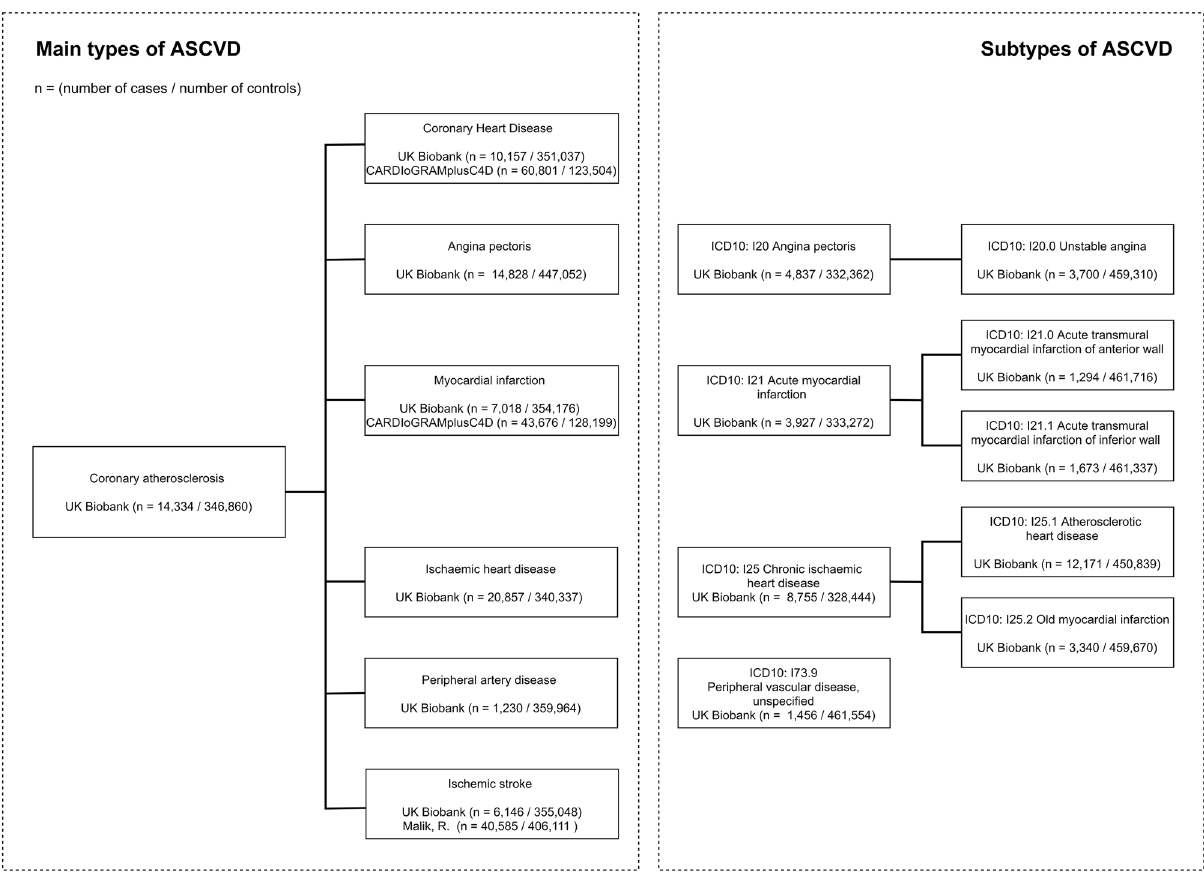
Figure 1. The flow chart of ASCVD outcomes and sources of